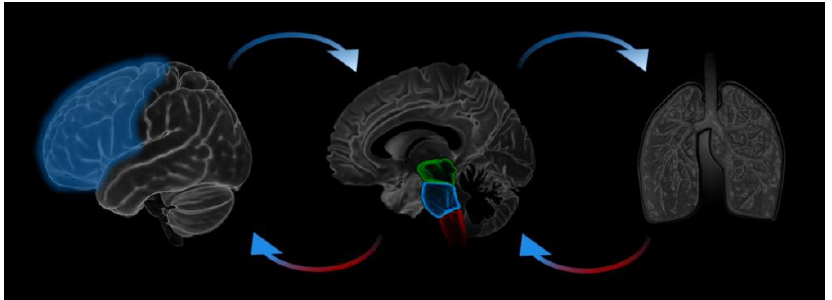
Figure 1. Three-way coupled oscillation of breathing, neurocognitive cortical processes and subcortical LC/NA modulation.